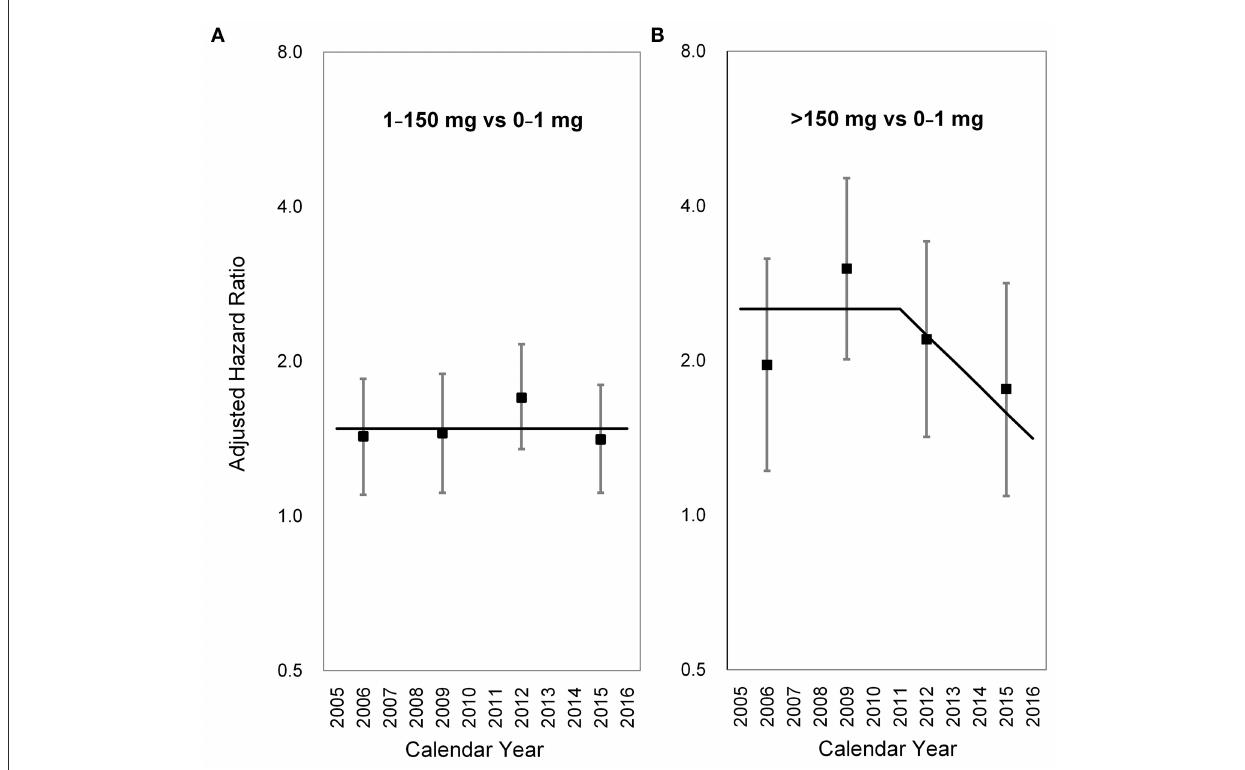
FIGURE2 Long-term trends in the adjusted hazard ratio for upper tract urothelial carcinoma occurrence. (A) 1–150mg vs. 0–1mg, (B) > 150mg vs. 0–1mg. Square points: adjusted hazard ratios from the piecewise constant hazard model. Vertical lines: 95% confidence intervals of the adjusted hazard ratios from the piecewise constant hazard mode. Solid lines: adjusted hazard ratios from the slope-change